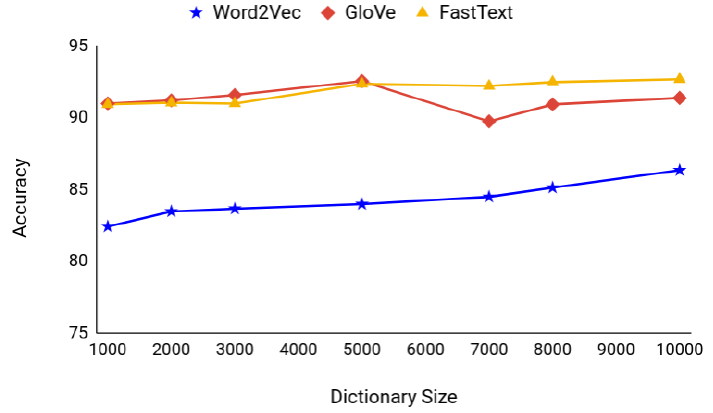
Figure 10. Graphical representation of Pairwise Accuracy of CNN Network over various dictionary lengths. The X-axis represents the dictionary sizes, and the Y-axis represents the accuracy. Neighborhood accuracy was also measured across various POS categories. The vo- cabulary was divided into the top four categories: nouns, verbs, adverbs, and adjec- tives. Cosine neighborhood accuracies were measured individually, within each category, as showcased in Table